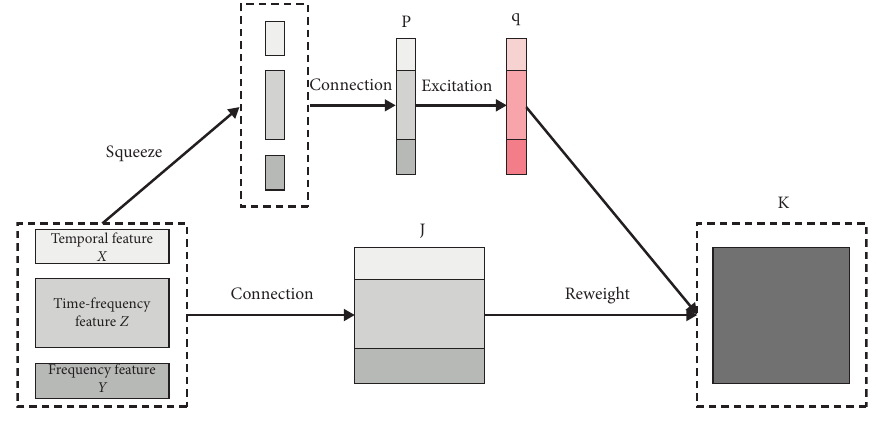
Figure 3: SCE module.